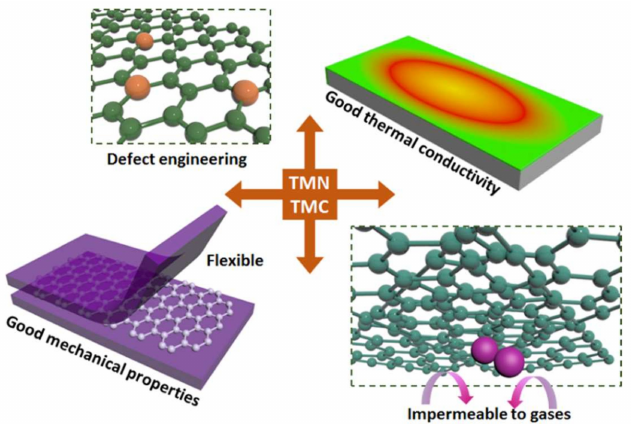
Figure 1. Schematic illustration of the properties of transition metal carbides (TMC) / transition metal nitrides (TMN) including